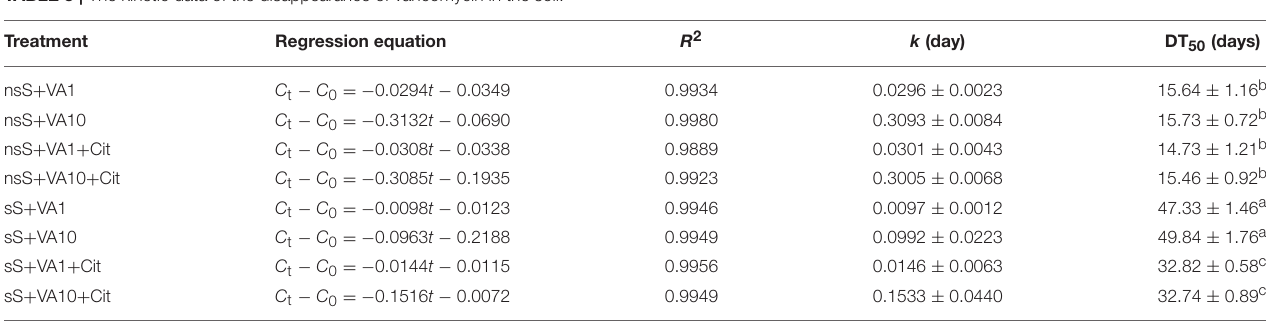
TABLE 3 | The kinetic data of the disappearance of vancomycin in the soil. Treatment Regression